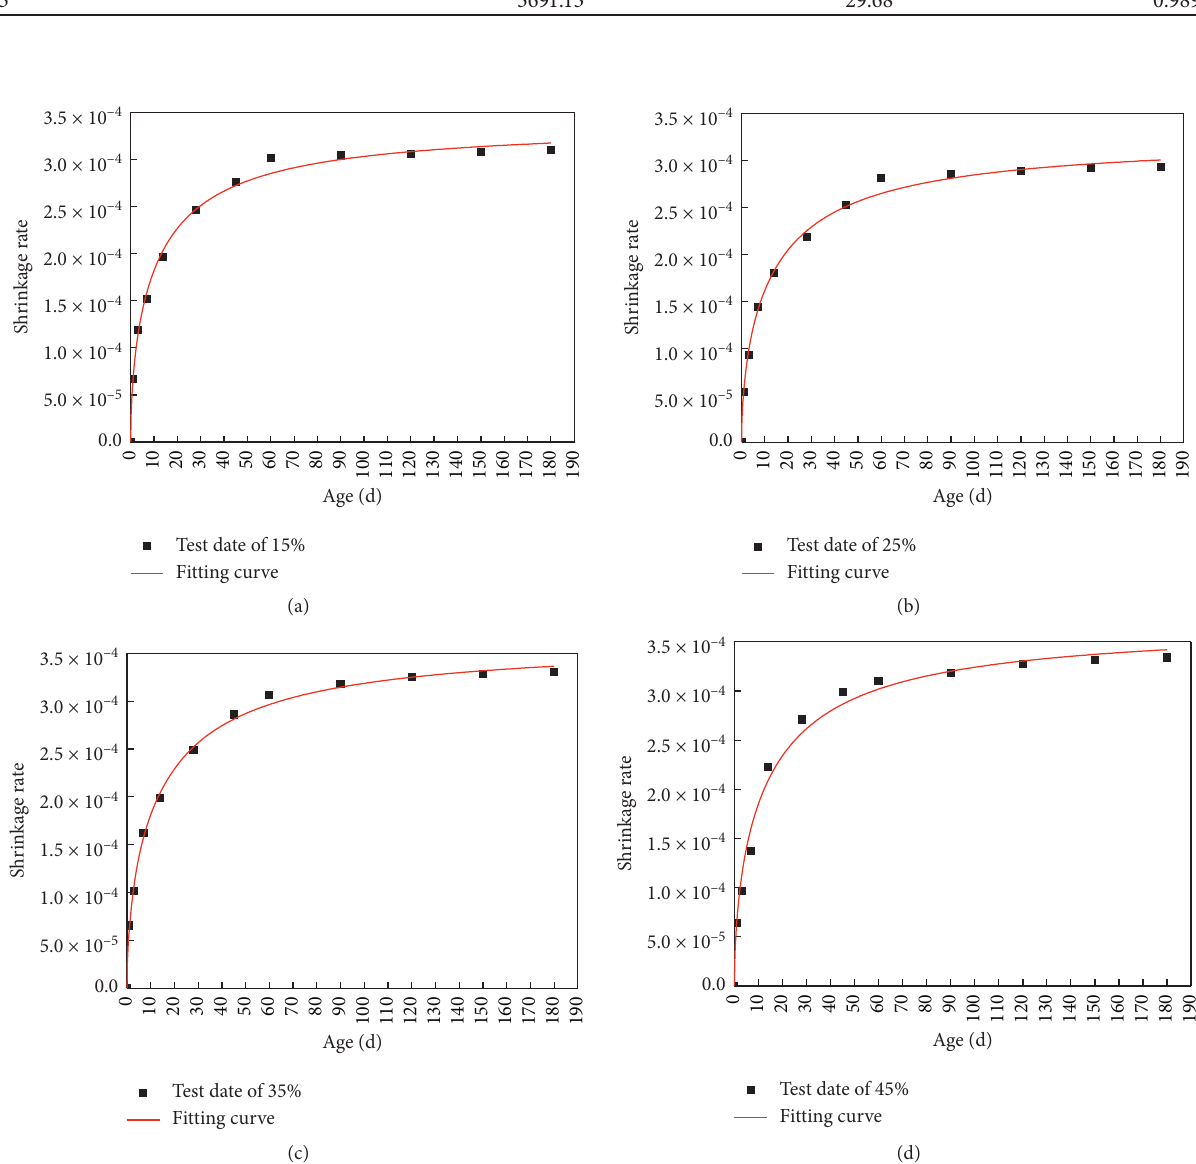
Figure 10: Goodness of fit for the modified theoretical shrinkage model developed in this study relative to the observed concrete shrinkage values obtained during experimentation: (a) 15% fly ash; (b) 25% fly ash; (c) 35% fly ash; (d) 45% fly ash.